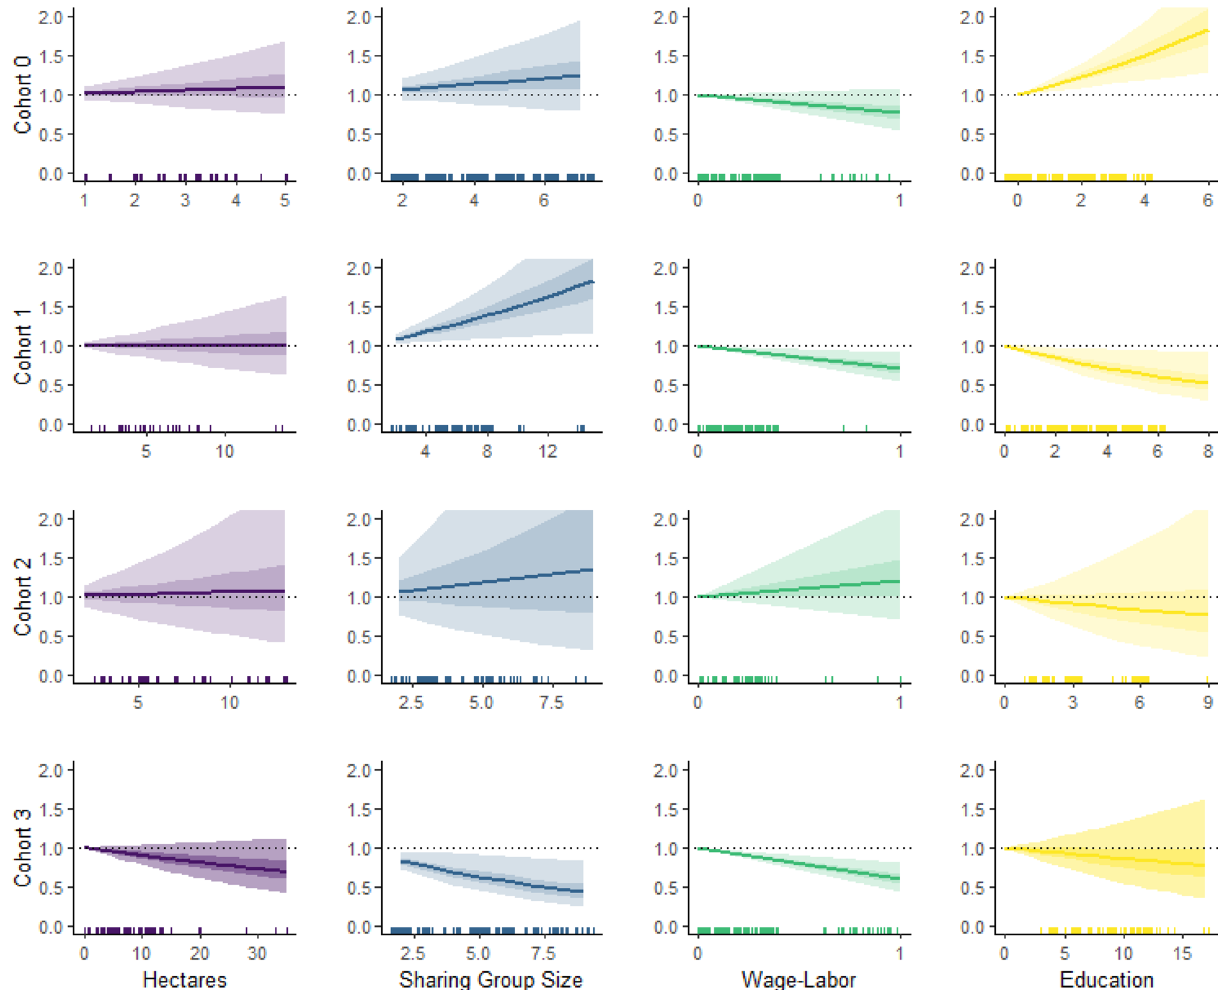
Figure 3. Adjusted hazard ratios. Lines reflect the % increase in the yearly probability of giving birth compared to baseline for a given increase in the covariate. The baseline reflects the hazard rate for women at a value of 0 for the covariate. Shaded areas reflect the 50% and 95% of the simulated distribution of coefficients 66 . Statistically significant effects do not overlap with the dotted line (also see Table 4). Raw data plotted on x-axis have been jittered, and are on different scales. Note that the positive association between education and fertility in Cohort 0 is likely not meaningful as an exception to the robust cross-cultural finding that education and fertility are usually negatively associated. In Cohort 0, completed education averages 1.3 years, with less than 4 years as the maximum schooling for any girl (Table 2). Given the low levels and young age at completed education, girls, if they did go to school, would not have faced trade-offs between continuing schooling and starting a family.